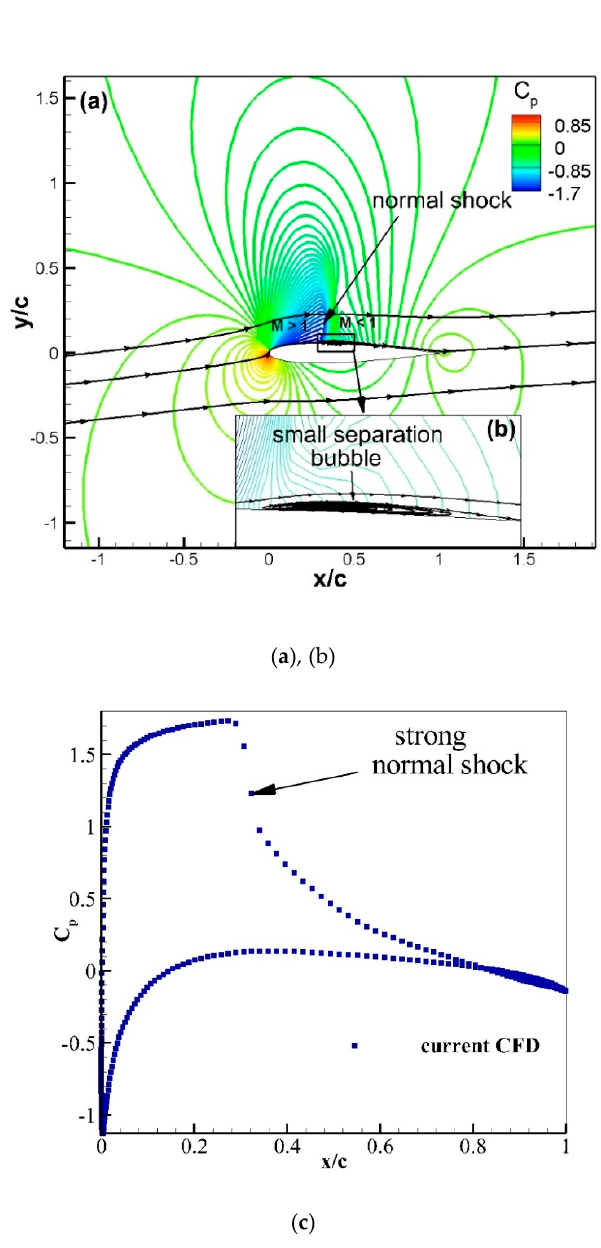
Figure 10. ( a ) Computed coefficient of pressure contours with subfigure ( b ) depicting the shock boundary layer interaction separation bubble. ( c ) Computed surface pressure coefficient for the NACA0012 airfoil at Mach = 0.7 and Re ∞ = 9 × 10 6 at an angle of attack = 4.8°.